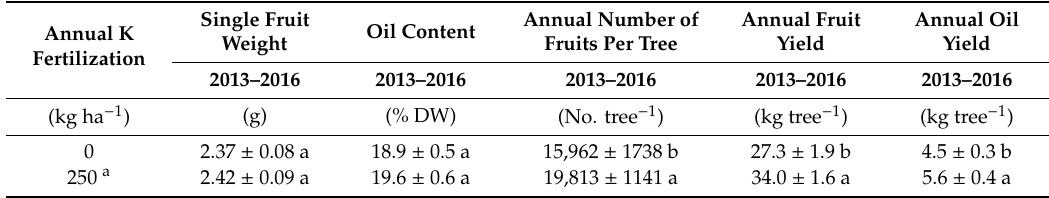
Table 4. Influence of K fertilization on alternate